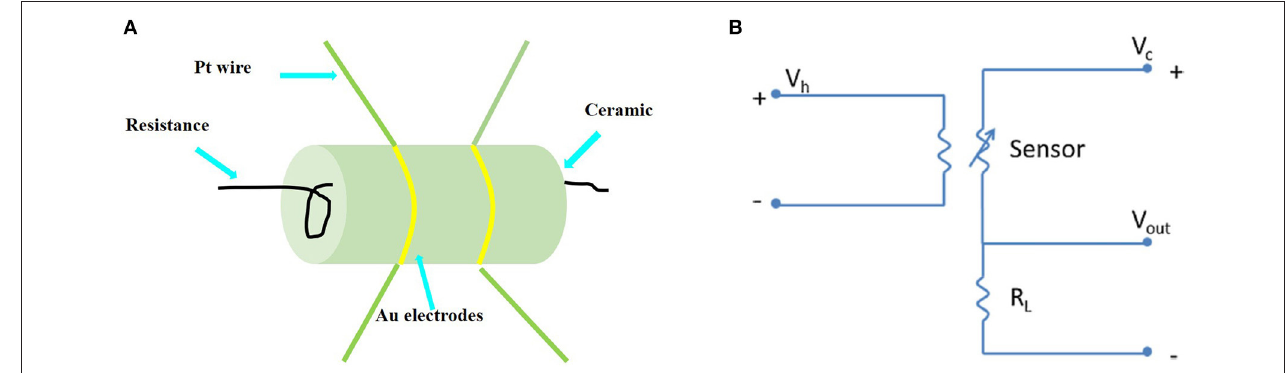
FIGURE 1 | (A) Sketch of the structure of the side-heated mesoporous WO 3 NFs based gas sensor. (B) Electric circuit of gas sensing